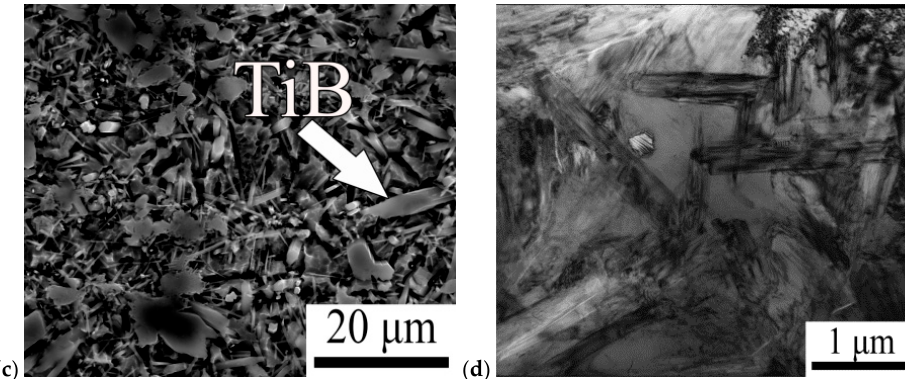
Figure 2. Microstructure of the Ti-15Mo/TiB titanium–matrix composite (TMC) in the initial condition: ( a ) XRD pattern, ( b ) SEM image of unetched surface; ( c ) SEM image of etched surface; ( d ) TEM bright field image.